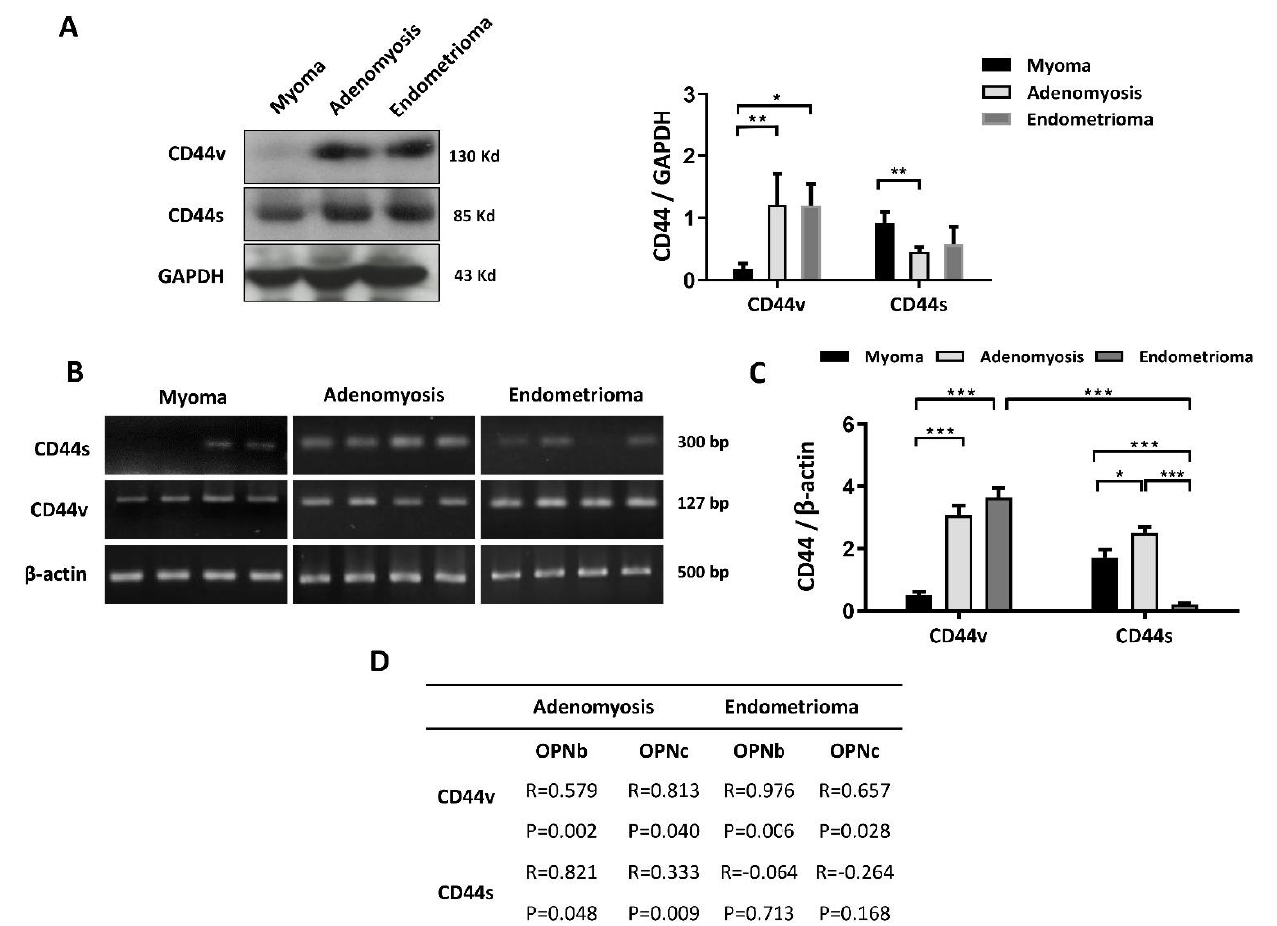
Figure 2. Differential expression of OPN ligand-receptor CD44s and its variant CD44v in endometriotic samples. ( A ) Quantification of proteomic data from controls and endometriotic tissues showed increased CD44v expression in endometriosis tissues. In contrast, both adenomyosis and ovarian endometriosis demonstrated slightly reduced CD44s expression. ( B ) The representative electrophor etogram of CD44s, CD44v, and β -actin in myoma, adenomyosis, and endometrioma is shown. ( C ) Normalized CD44 mRNA expression demonstrated the overexpression of CD44v in ad- enomyosis and ovarian endometrioma samples. In comparison to myoma cells, the CD44s variant was found to be overexpressed in adenomyosis cells but was diminished in endometrioma cells. ( D ) The linear correlation between the expression levels of CD44 variants and OPN isoforms in various endometriotic tissues. Plots represent the mean ± SEM. CD44s: CD44 standard; CD44v: CD44 vari- ant. ( * ) indicates a significant difference with p < 0.05. ( ** ) indicates a significant difference with p < 0.01. ( *** ) indicates a significant difference with p < 0.001. The EMT process was prominent in ectopic endometrial tissue: Vimentin and N-cad- herin levels increased in both adenomyosis and endometrioma, while a decrease in the epithelial marker E-cadherin was found only in adenomyotic tissue ( p < 0.05) (Figure 3A). Electrophoretogram and qPCR analysis highlighted the overexpression of N-cadherin and Vimentin in endometriotic cells, while the corresponding suppression of E-cadherin was also observed (Figure 3B,C). The cell adhesion molecules ICAM and VCAM were used as the biomarkers for endometriosis and contribute to EMT progression. Both adenomyosis and endometrioma tissues had elevated ICAM and VCAM mRNA expression levels.